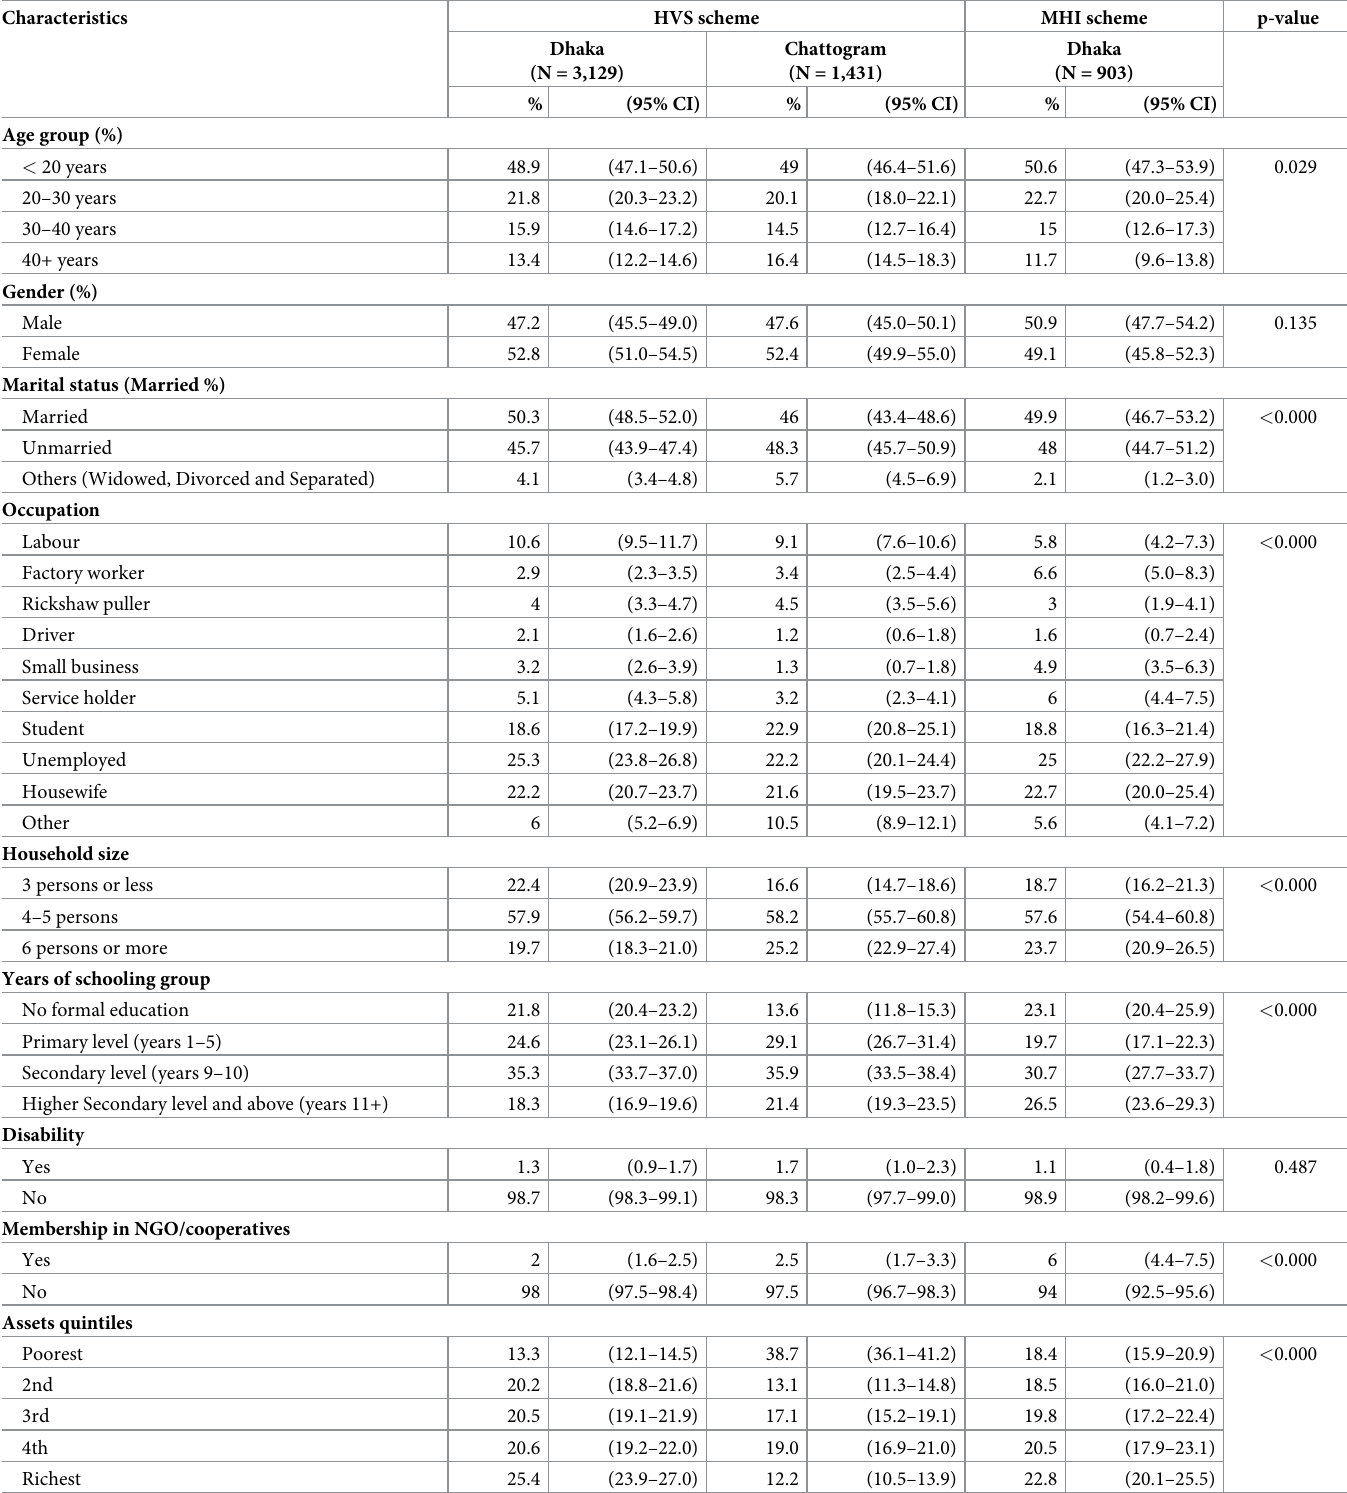
Table 4. Characteristics of the individual beneficiaries (household